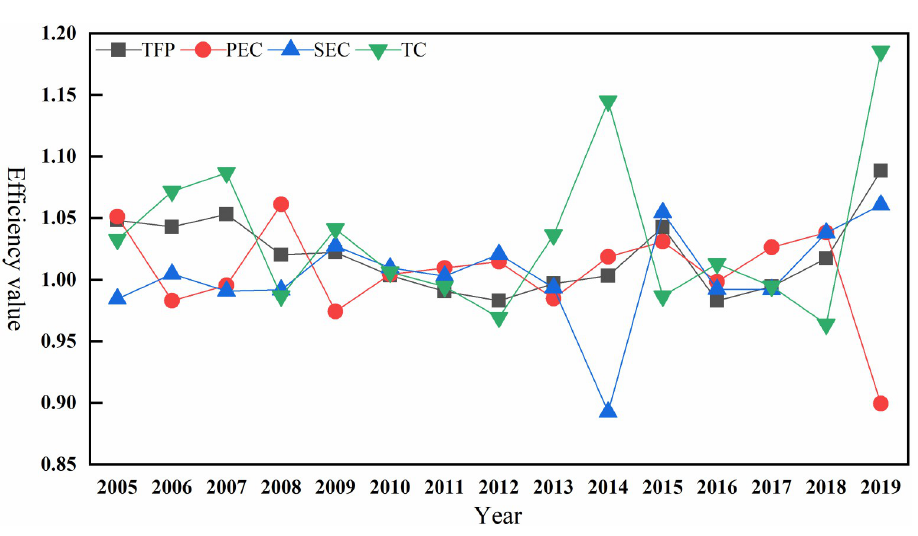
Fig 1. Changes in the numerical distribution of TFP for urban economic development in